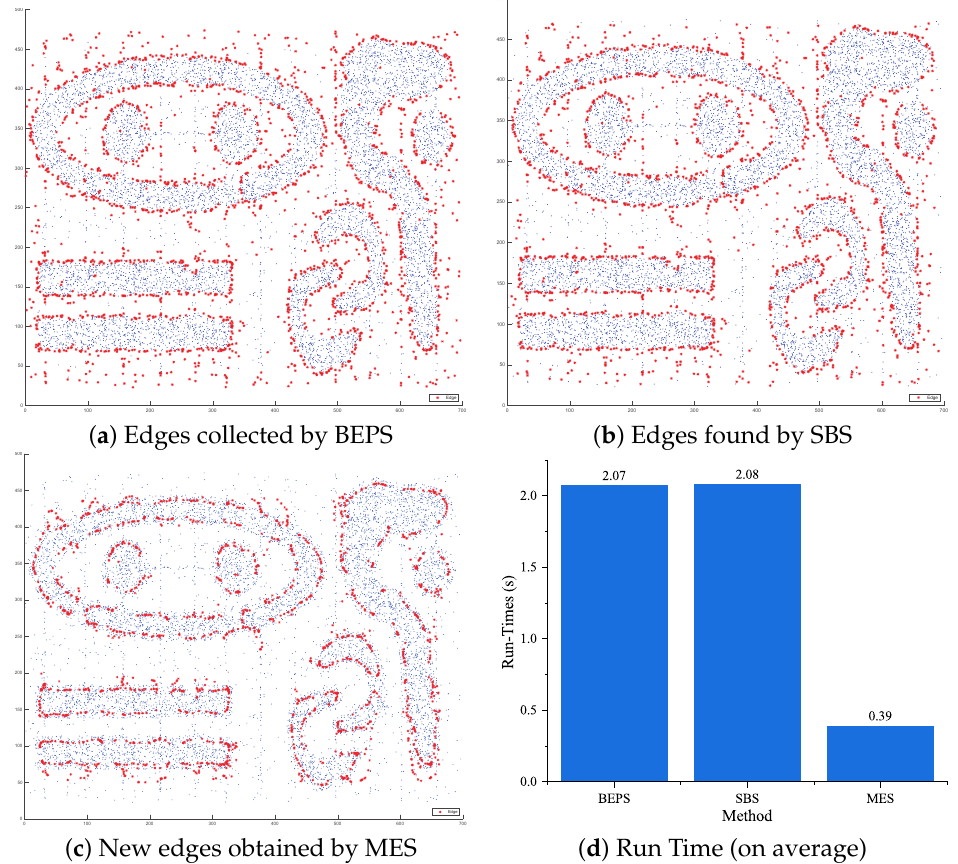
Figure 4. Edges collected by BEPS [15], SBS of BSVC [8], and MES of IBSVC on DS3 provided by [16]. ( a ) BEPS: k 1 = 30, γ = 0.8. ( b ) BSVC: k 1 = 30, γ l = 0.8, γ u = 0.95. ( c ) MES: K = 20, k 1 = 30, k 2 = 5, γ l = 0.8, γ u = 0.95, τ f = 0.25. ( d ) The average run-time cost in